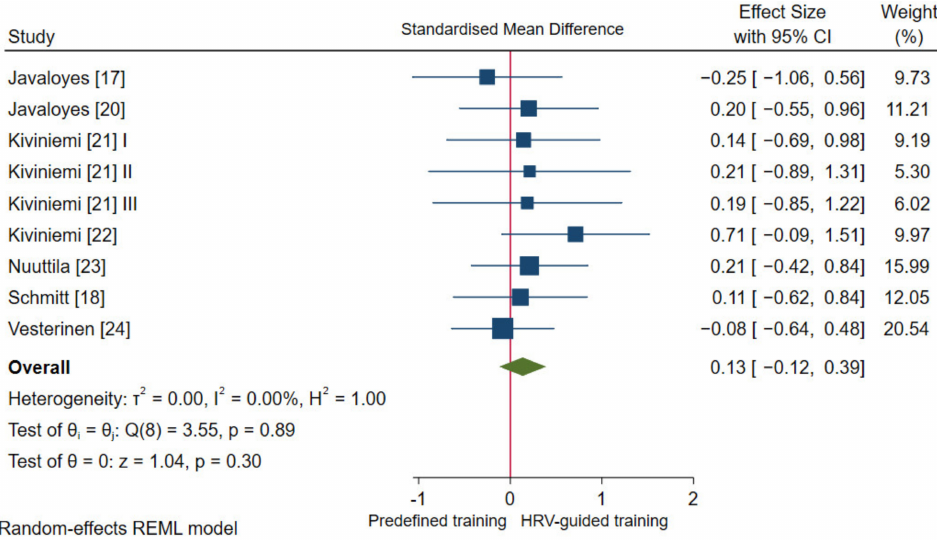
. VO 2 max. I, II, III refer analysis